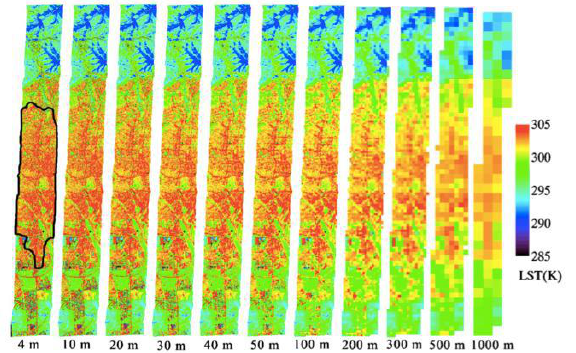
Figure 2. Land Surface Temperature (LST) observations with different spatial resolutions over Madrid. The leftmost panel (4 m resolution) shows the outline of Madrid’s municipal boundaries in black (from Sobrino et al., 2009).